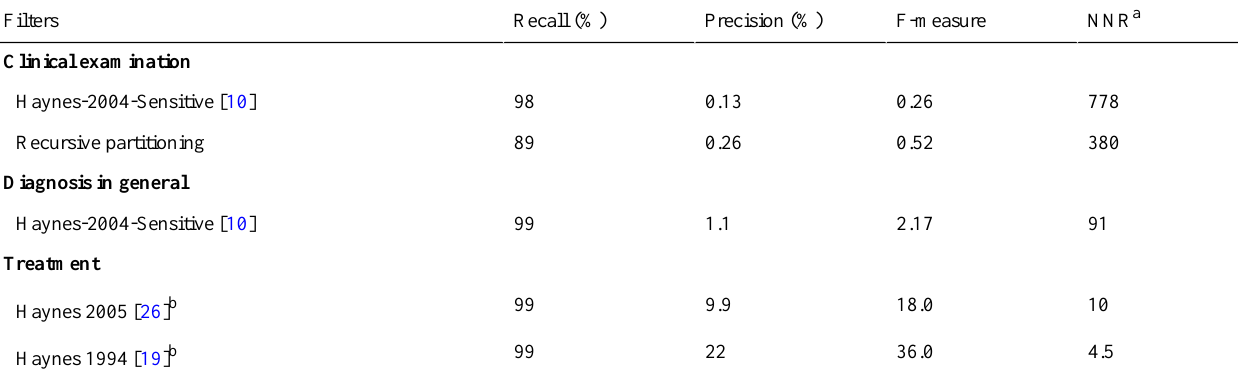
Table 4. Comparison of the performance of filters for clinical examination, diagnosis, and